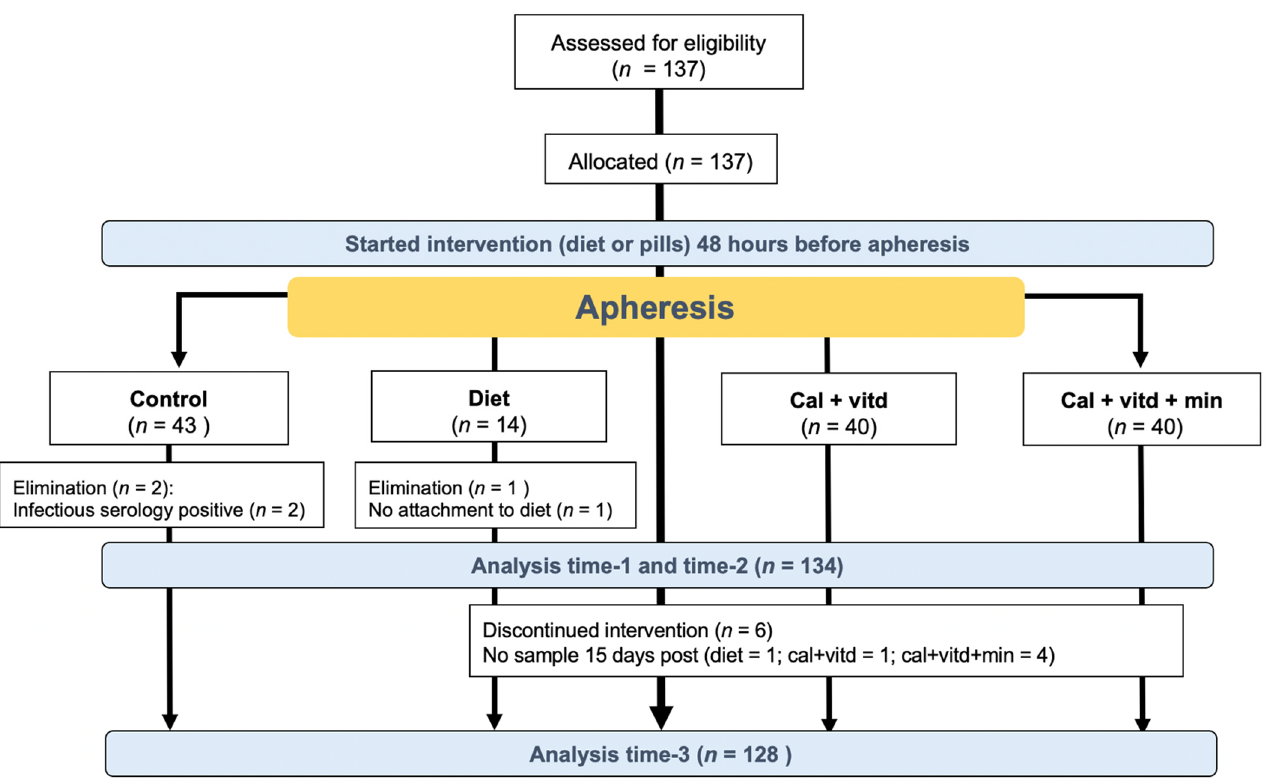
Figure 1. Flowchart of the studied population. Control: no supplementation; Diet: diet; cal + vitd: calcium carbonate + vitamin D; cal + vitd + min: calcium carbonate, minerals + vitamin D. Blood samples were taken at the beginning (time-1); after finishing the plateletpheresis (time-2); and fifteen days later from the participating donors (time-3). Table 1. General characteristics of donors by study